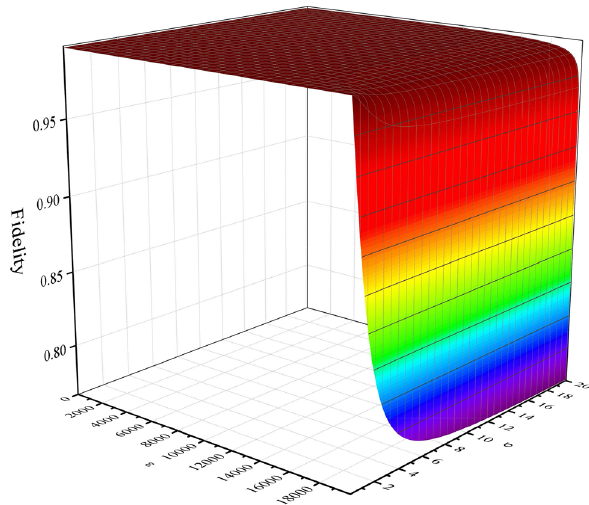
Fig. 12 Thefidelityofthequantumteleportation, F 3 asdefinedin(88), asafunctionofthevolume ε andtherapidity σ ofthecosmicexpansion. The parameters of the two originally entangled qubits A and B are the same. The energy gap of each of them is (cid:15) = 2, the inner product of the mode functions, defined in Eq. (21), is μ = 0 . 1. The mass of the scalar field particle is m = 0 . 01. The state teleported from qubit C to ( | 0 (cid:7) + | 1 (cid:7) B is 1 √ 2